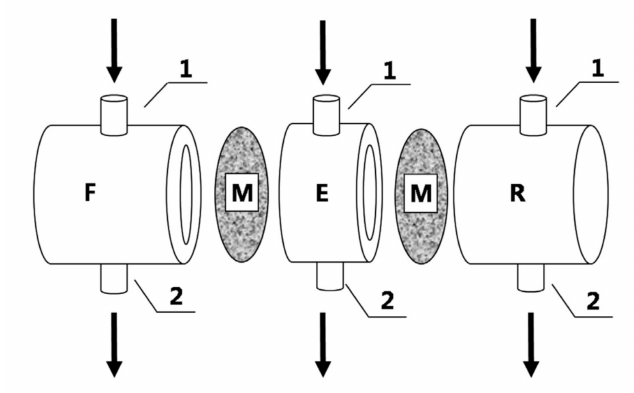
Figure 7. Schematization of flowing liquid membrane system. F, E, and R: feed, organic, and strip compartments; M: separation membranes. 1 and 2: inlet and outlet of the feed, organic, and strip solutions